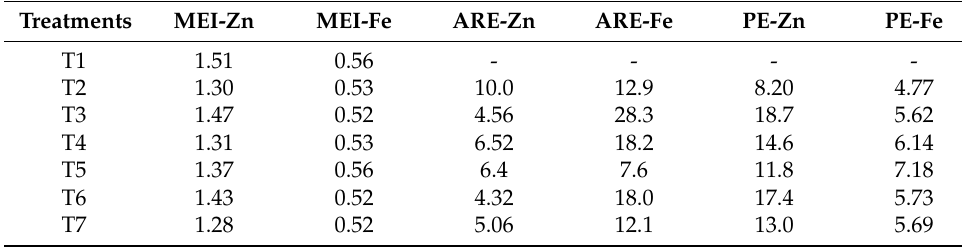
Table 7. Effect biofortification on efficiency indices of